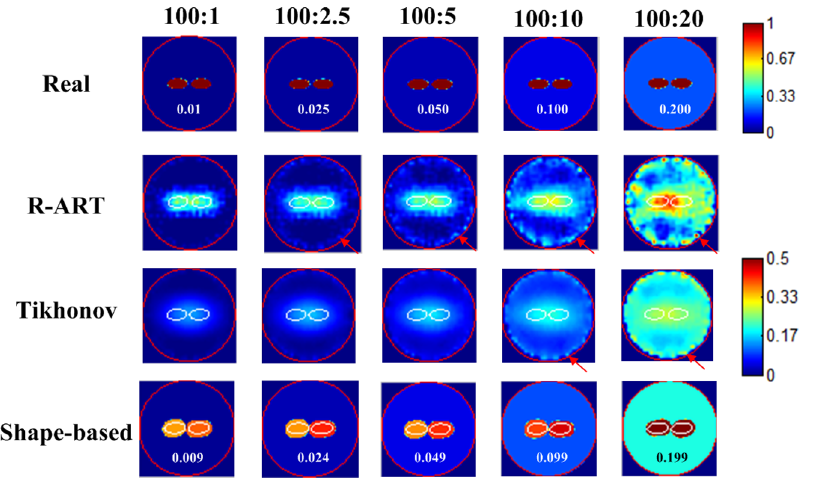
Figure 7. Reconstruction results of different fluorescence contrasts. The red circle denotes the boundary of the imaged object, and the white lines denote the boundaries of the real inclusions. The slice images are of 3.0 cm height.